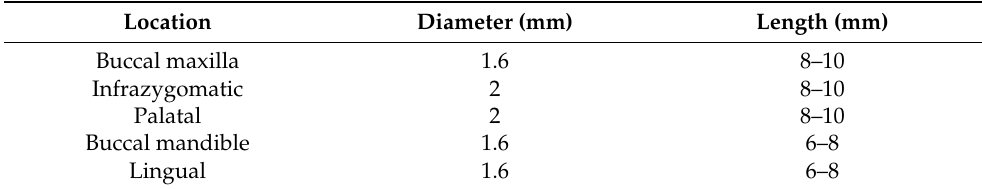
Table 1. Diameter and length used depending on the insertion